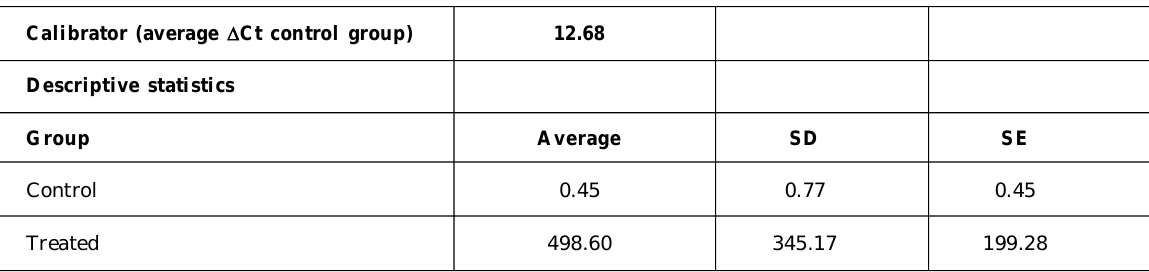
Table 4: Descriptive analysis for  ct values of LMCESE9 primers in each sample and average value of calibrator generated from control group (normalizer) Calibrator (average  Ct control group) 12.68 Descriptive statistics